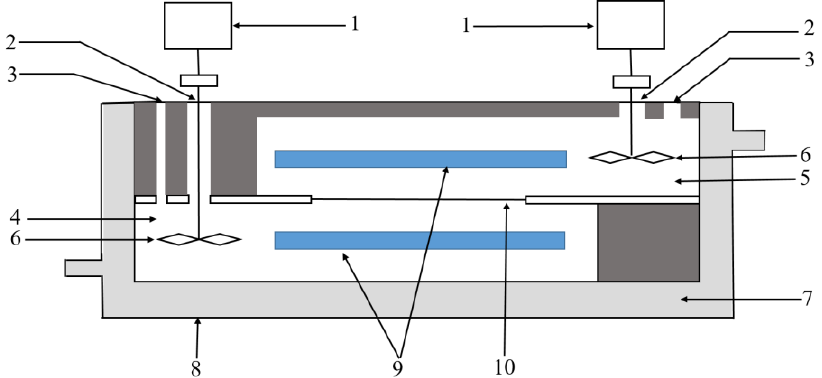
Figure 1. Structure of constant interfacial area cell with laminar flow: (1) agitator; (2) liquid inlet hole; (3) sampling hole; (4) aqueous phase circulation chamber; (5) organic phase circulation chamber; (6) stirring paddle; (7) thermostatic water; (8) thermostatic bath; (9) guide plate; and (10) interface plate.